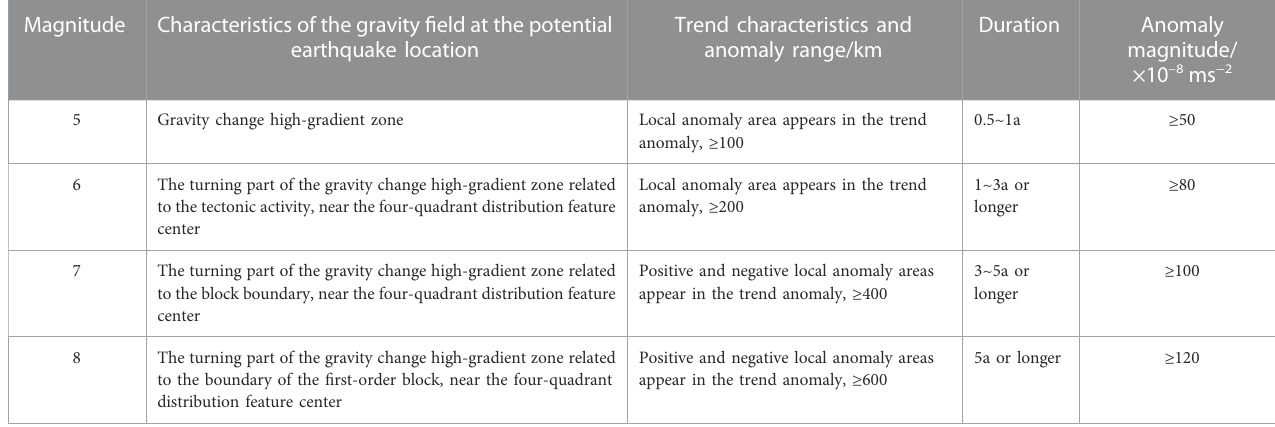
TABLE 1 Relation between the gravity anomaly and earthquake preparation (Zhu et al., 2022).